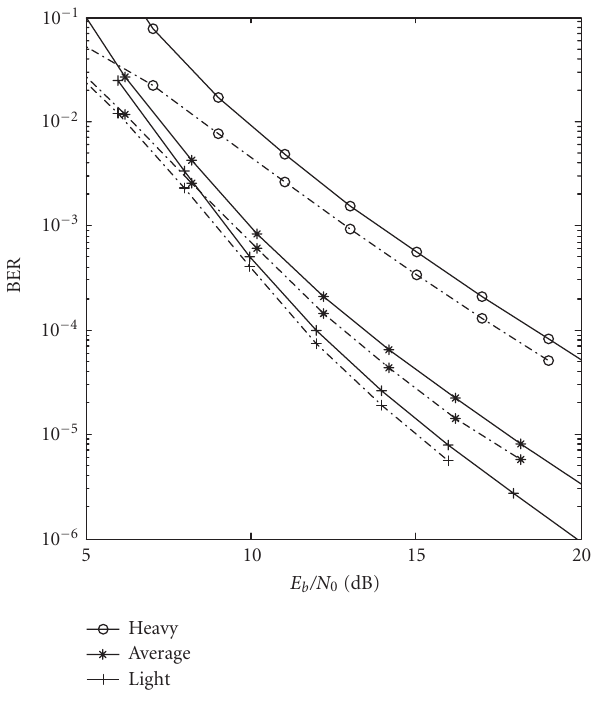
Figure 4: Upper bounds versus simulation results for code F2 (solid: upper bounds, dashed: